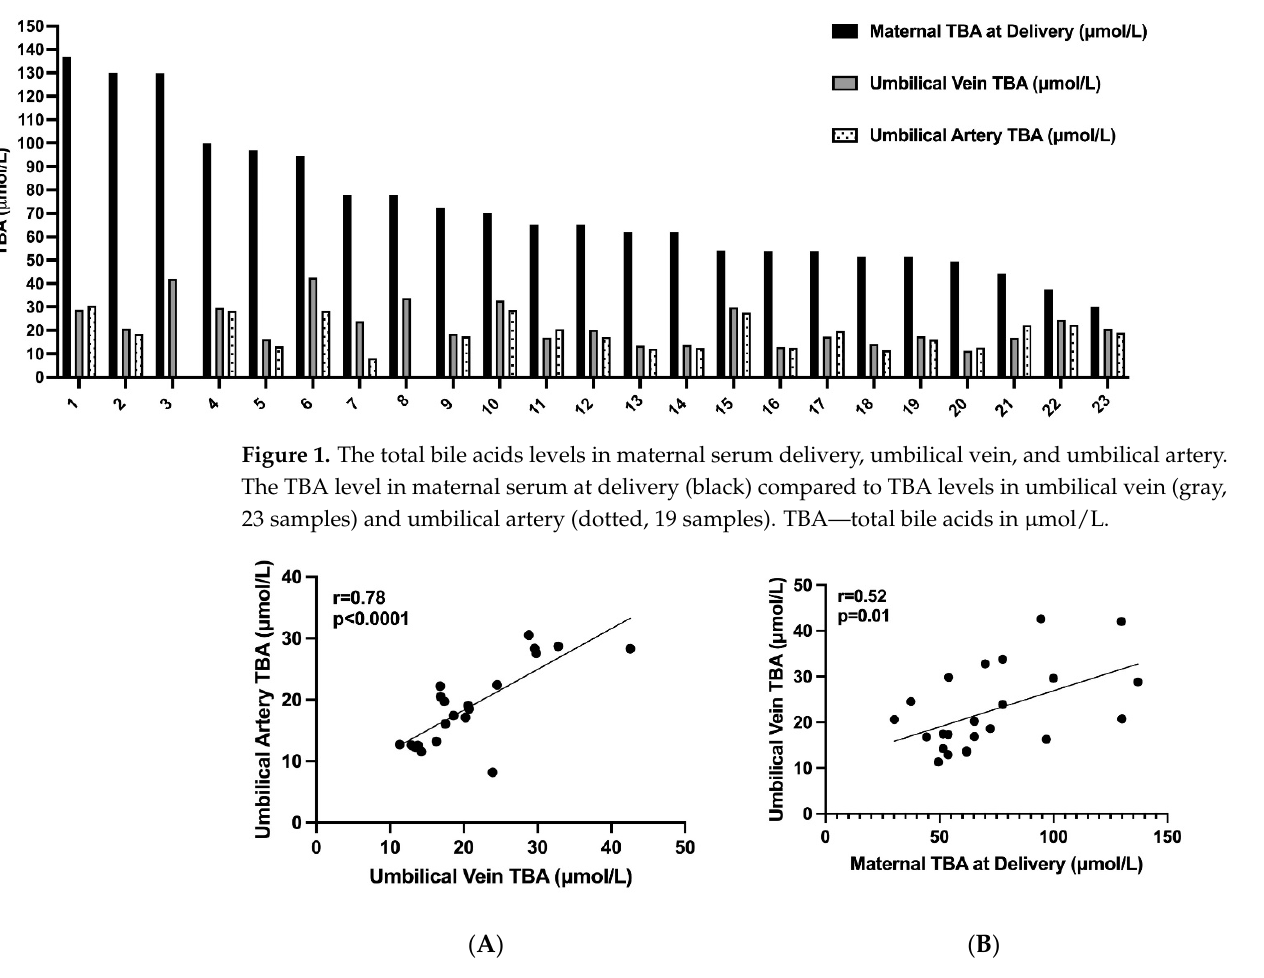
Figure 2. The correlations between maternal and fetal TBA levels. Graphic diagrams which show the correlations between maternal and fetal TBA levels. ( A ) A positive correlation between TBA levels in umbilical artery and vein (r = 0.78, p < 0.0001), ( B ) A positive correlation between TBA levels in maternal serum at delivery and umbilical vein (r = 0.52, p = 0.01), TBA—total bile acids in μ mol/L.